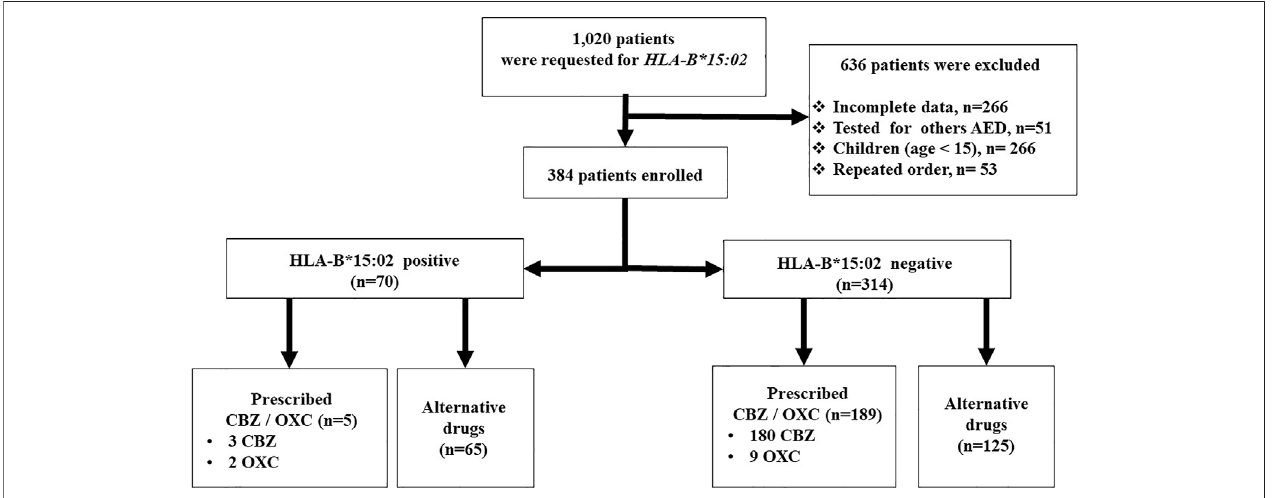
FIGURE 1 | The fl owchart of patients recruitment and clinical decision in HLA-B*15:02 positive (n = 70) and HLA-B*15:02 negative (n = 314) in Ramathibodi Hospital, Bangkok.